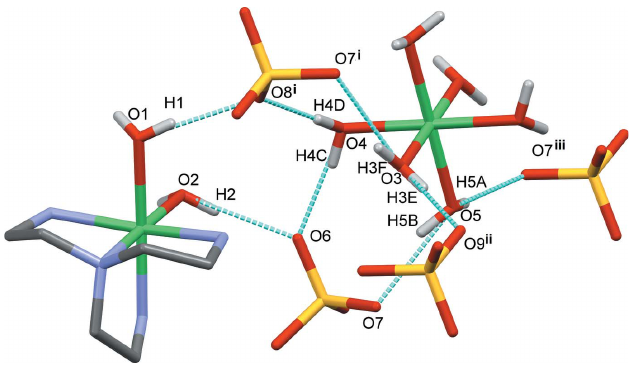
Figure 2 The hydrogen-bonding network (cyan dotted lines) in the title compound. 2+ and (cid:2) y , z for [Ni(H Symmetry codes: (i) x + 1 2 O) 6 ] 2 (cid:2) y + 1, z + 1